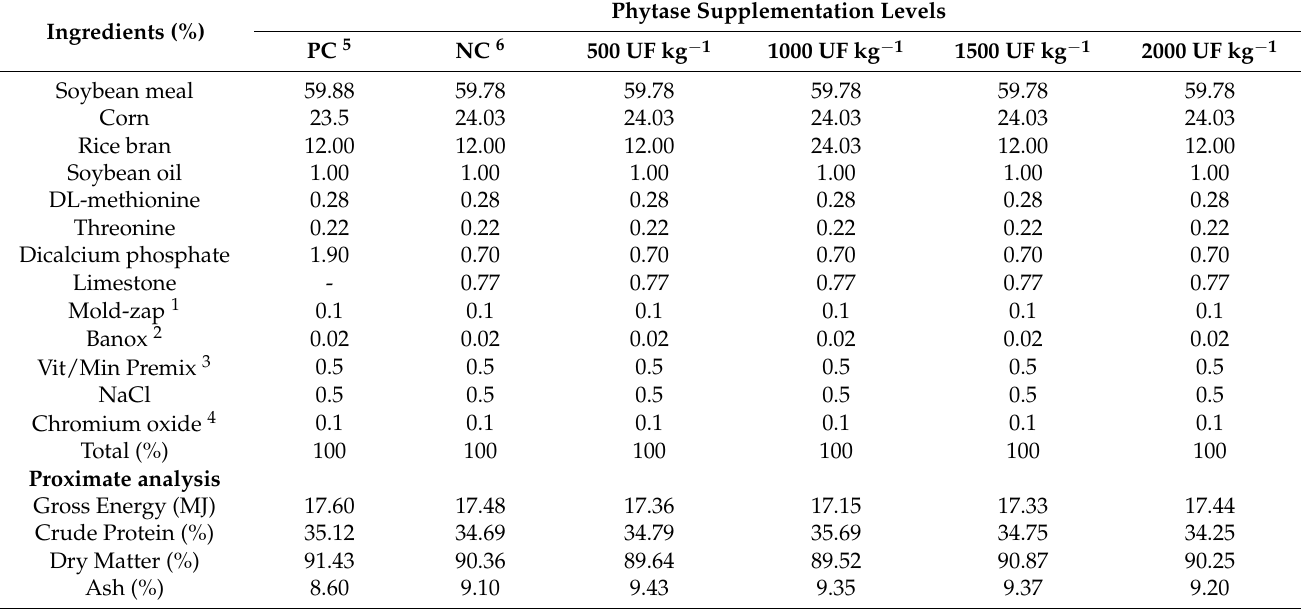
Table 1. Formulation and proximate composition of experimental diets containing graded levels of phytase